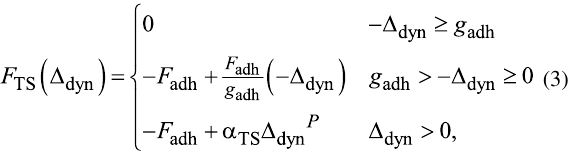
where w *( L 1 ) is the equilibrium deflection of the cantilever